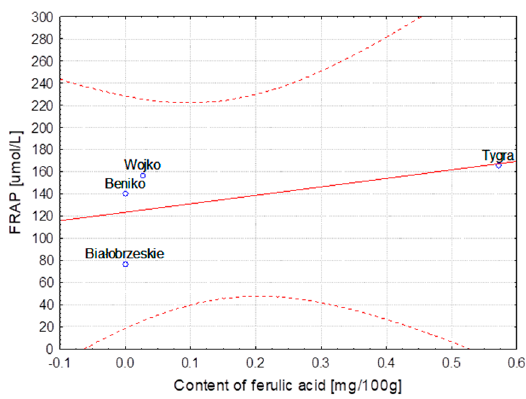
Figure 1. Method extraction of hemp—Dependence of FRAP [ μ mol/L] vs. content of ferulic acid [mg/100 g] (y = 87.057 + 64.243x; C = 95%).